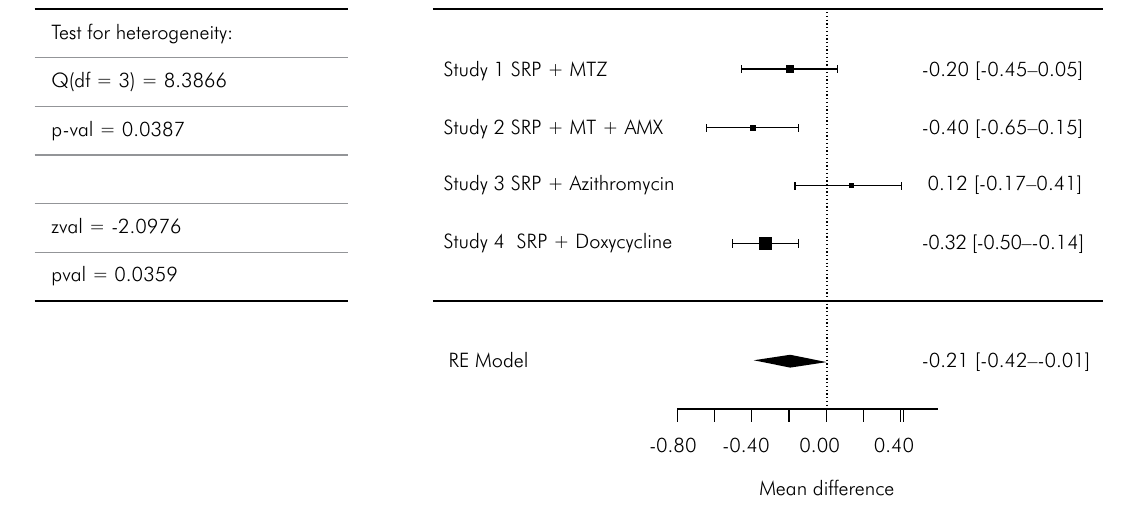
Figure 2. Forest plot for